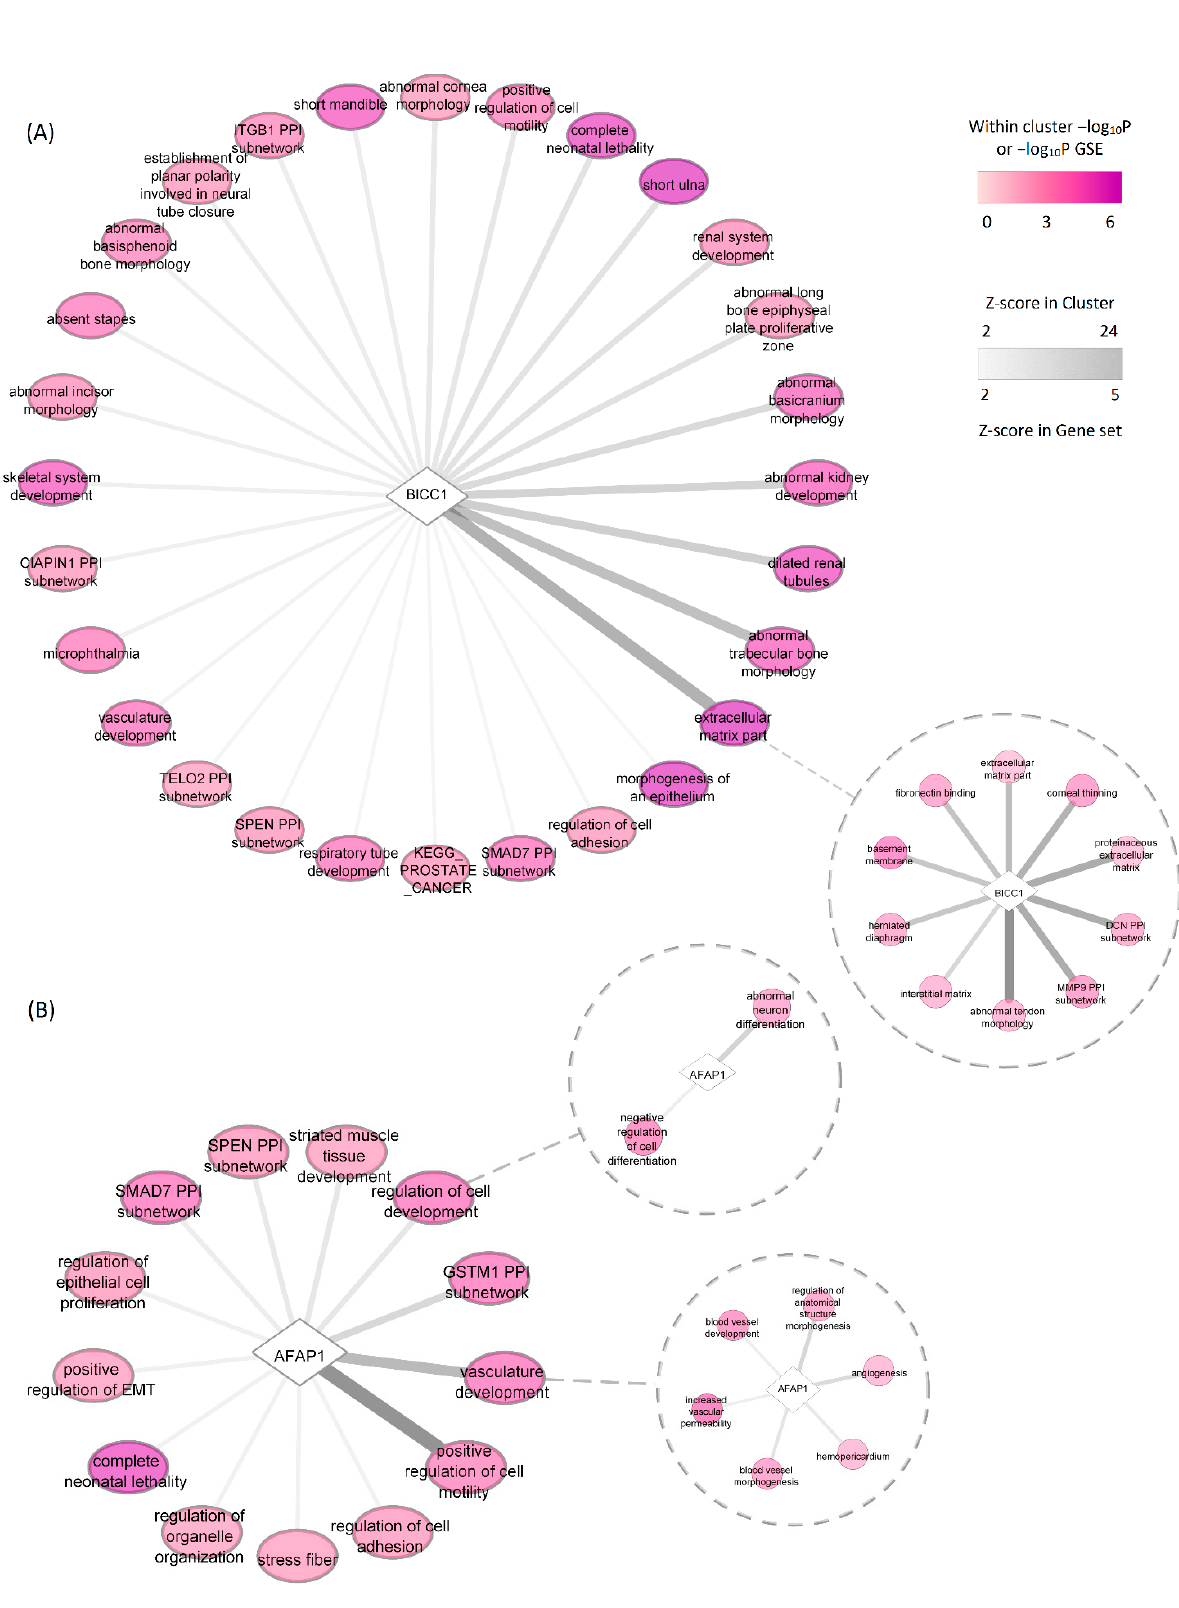
Figure 8. Correlation of BICC1 ( A ) AFAP1 ( B ) with DEPICT reconstituted gene sets. Ovals represent gene set clusters. Edges represent correlation Z-score which for gene set clusters is the sum of correlation with their individual gene sets. Detailed correlation of genes with individual gene sets (circles) within clusters is shown as subnetworks.